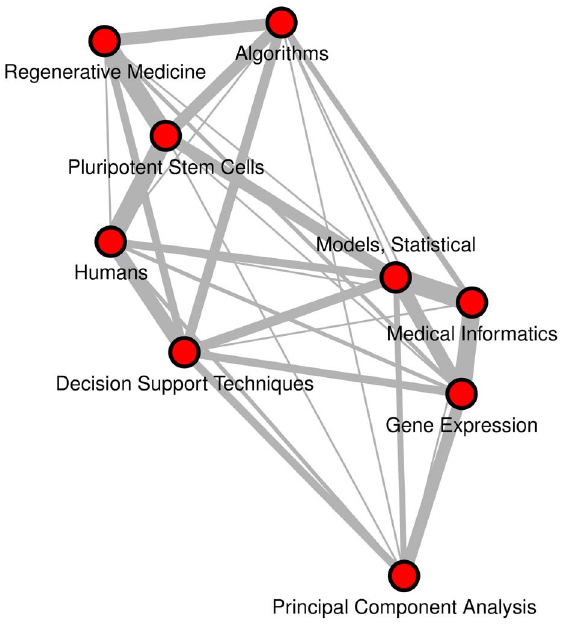
Figure 1. Toy example of the constructed network. Nodes represent MeSH descriptors. An edge between two MeSH descriptors is defined if they appear together in the same MEDLINE citation. Frequency of co-occurrence is represented by edge width. For example, the pair ‘‘Medical Informatics’’ – ‘‘Gene Expression’’ occurs in many more citations then does the pair ‘‘Principal Component Analysis’’ – ‘‘Pluripotent Stem Cells’’. Note, that we use frequency information only for network reduction purposes (i.e., to obtain a statistic which indicates whether a pair of descriptors occurs together more often than by